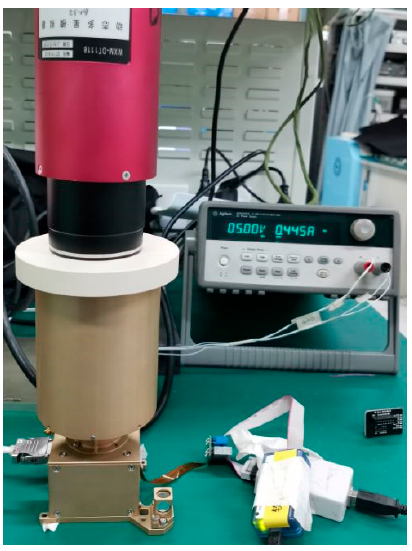
Figure 15. The verification platform.